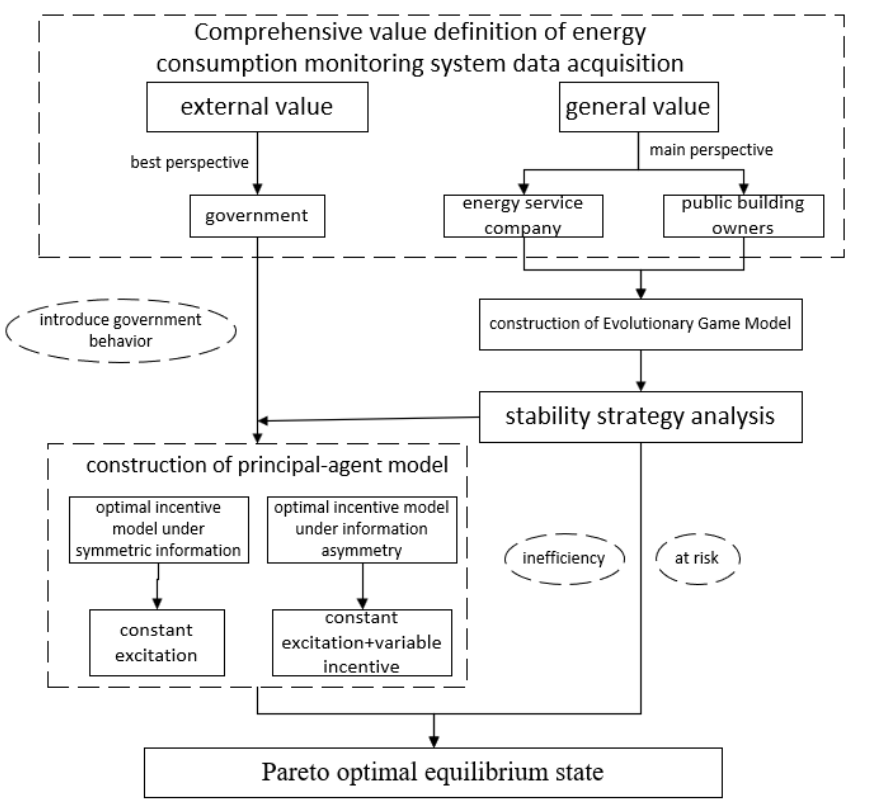
Figure 2. The technical route of dynamic game analysis.